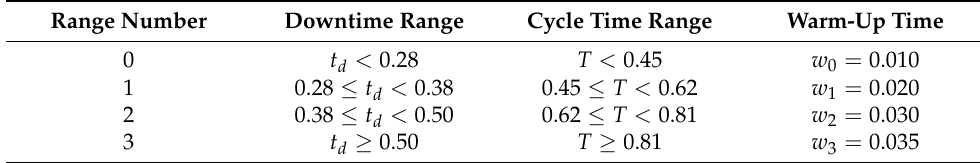
Table 5. Warm-up time diagram based on the downtime range with scrap items. Range